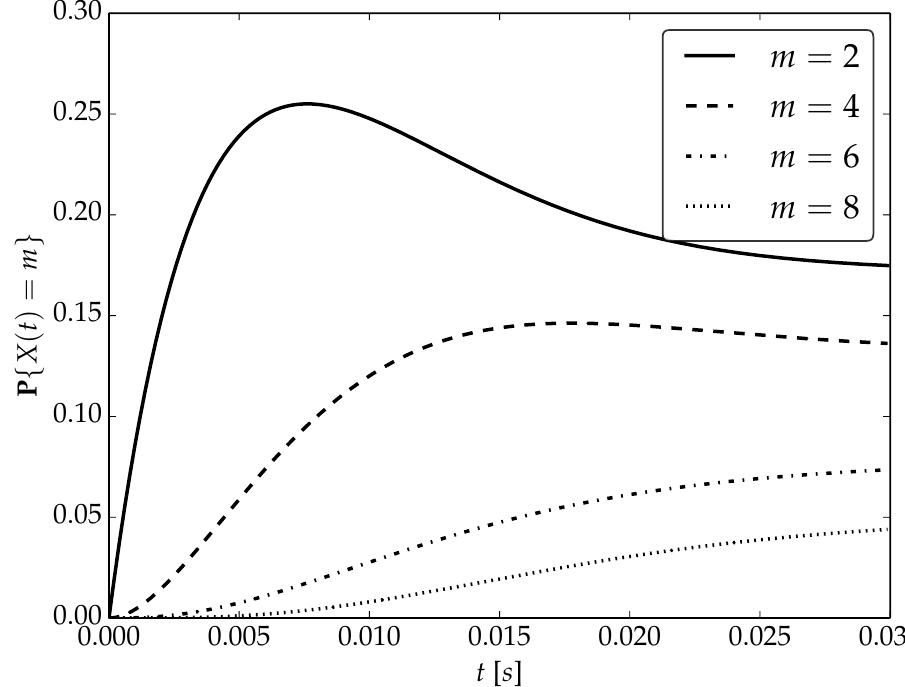
Figure 5. Transient distributions P { X ( t ) = m } for N = 4, batch distribution P 1 and ρ =